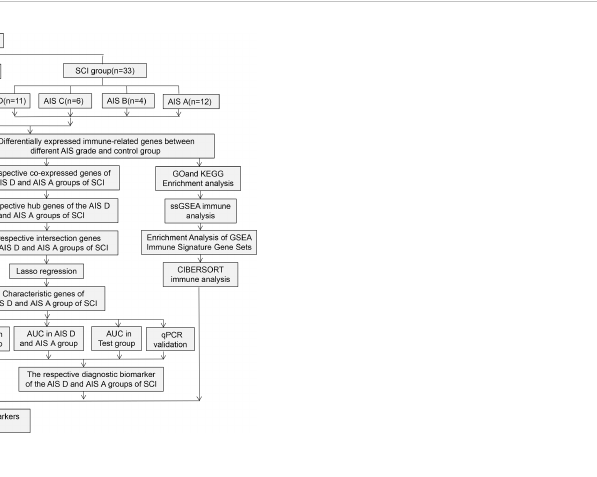
FIGURE 1 Flowchart of this research